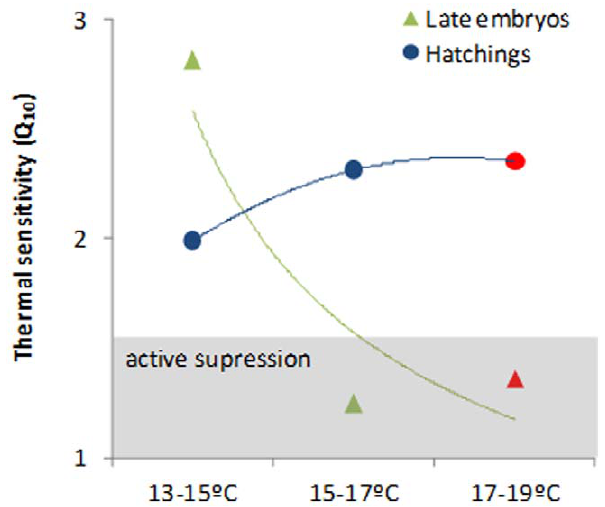
Figure 5. Thermal sensitivity (Q 10 ) of late embryonic stages and hatchlings of Loligovulgaris at the different temperature scenarios (red symbols highlight the future summer scenario). Coloured lines represent trendlines. Q 10 values between 2 and 3 indicate active metabolic regulation; Q 10 values inferior to 1.5 suggest active metabolic suppression.